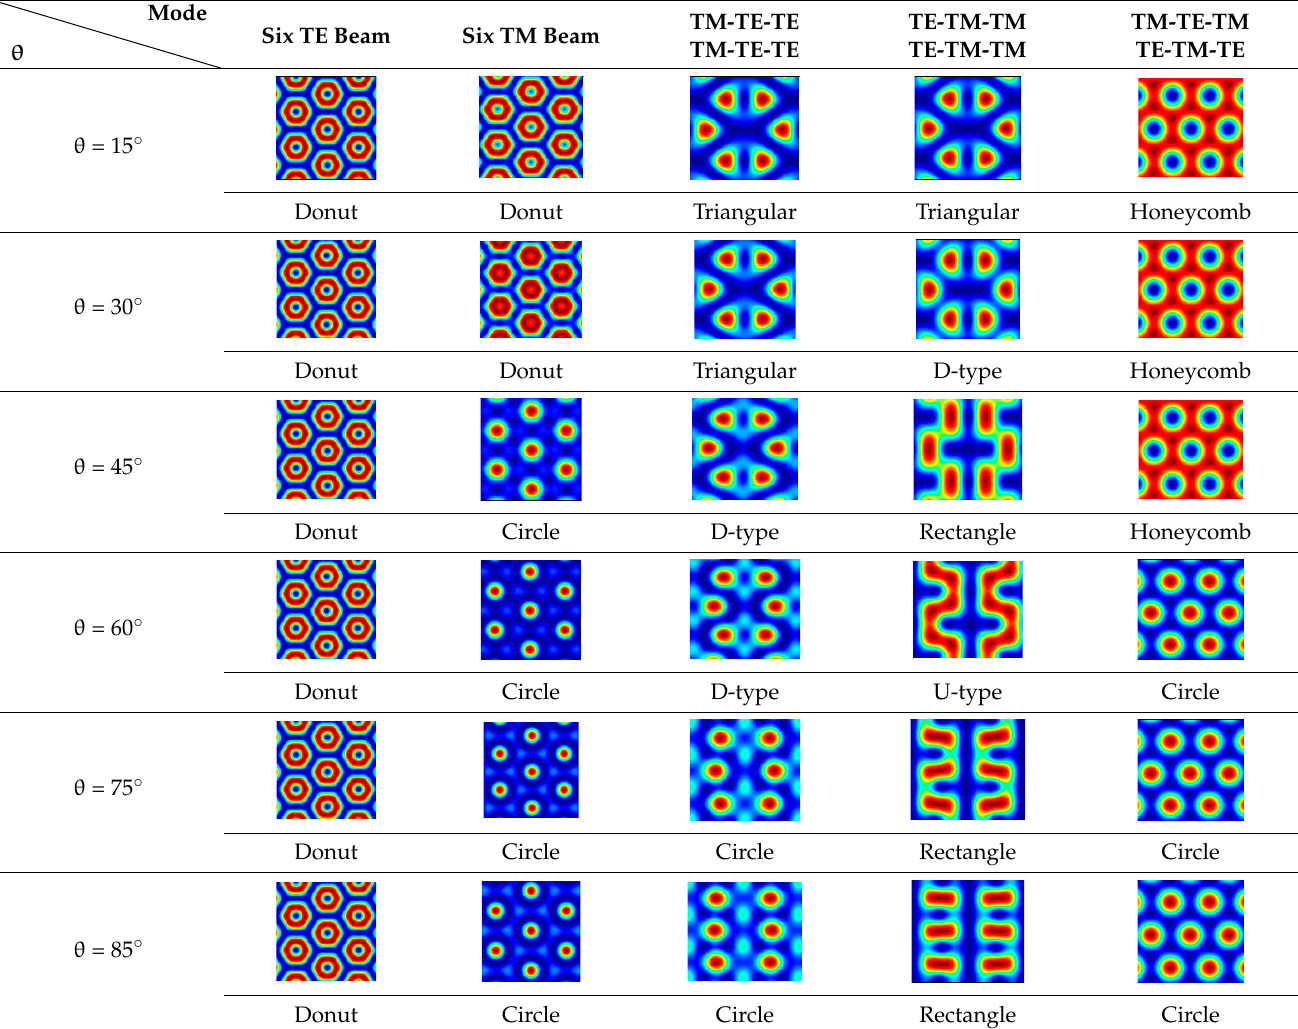
Table 1. Optical field distributions of microstructures with a six-beam LIL system. Mode